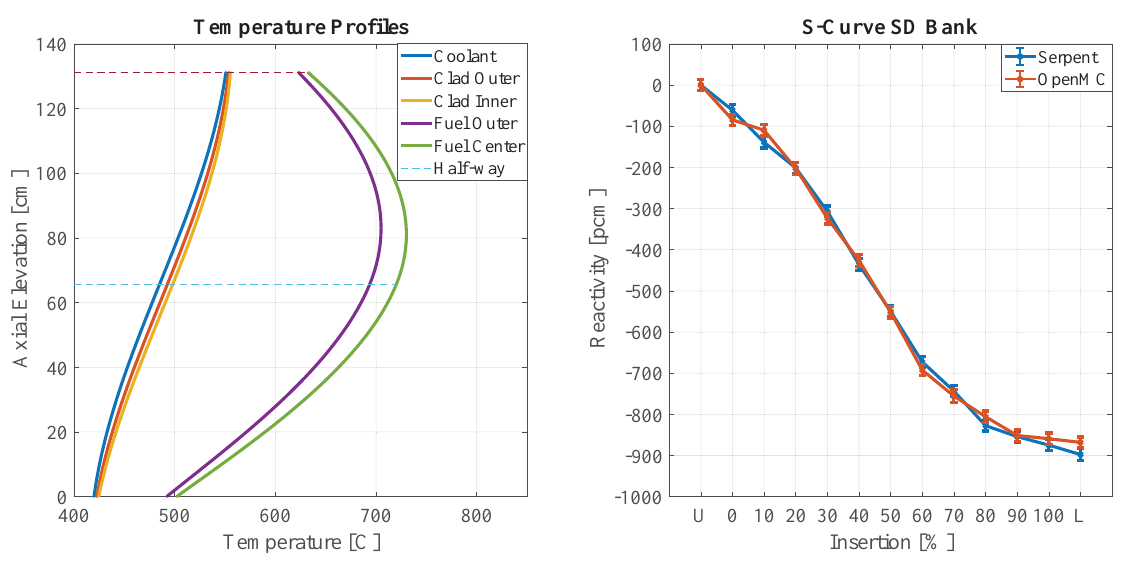
Figure 1: Thermal-hydraulics and Neutronics